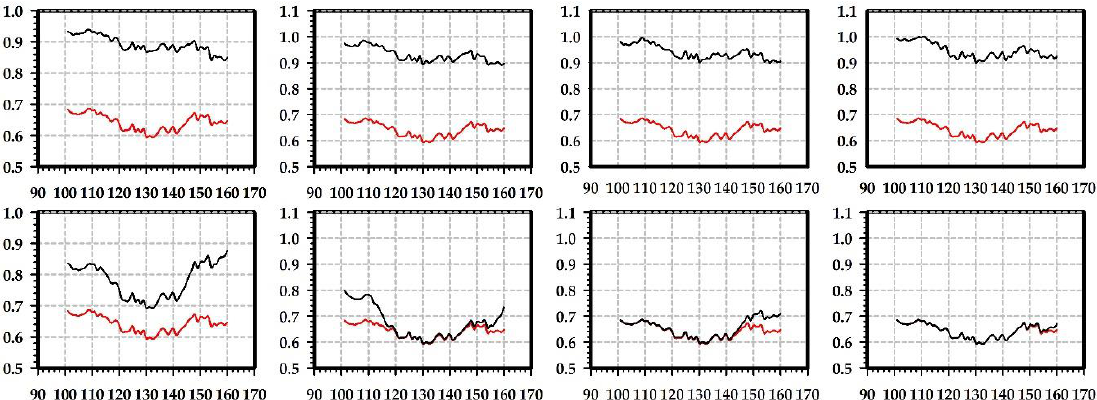
Figure 10. Illustration of generated highlight intensity distribution for the selected column of pixels with the marble material. First row: highlight effects generated by our Ashikhmin-based method, where images from left to right correspond to images of the first row in Figure 4; second row: highlight effects generated by the method based on the traditional Ashikhmin model, where images from left to right correspond to images of the second row in Figure 4 and the n t , n b parameters are n t is 2, n b is 2; n t is 2, n b is 10; n t is 10, n b is 2; n t is 10, n b is 10. In each image, the x axis is the vertical coordinate position of a pixel in the selected line and the y axis is the intensity value of the pixel.